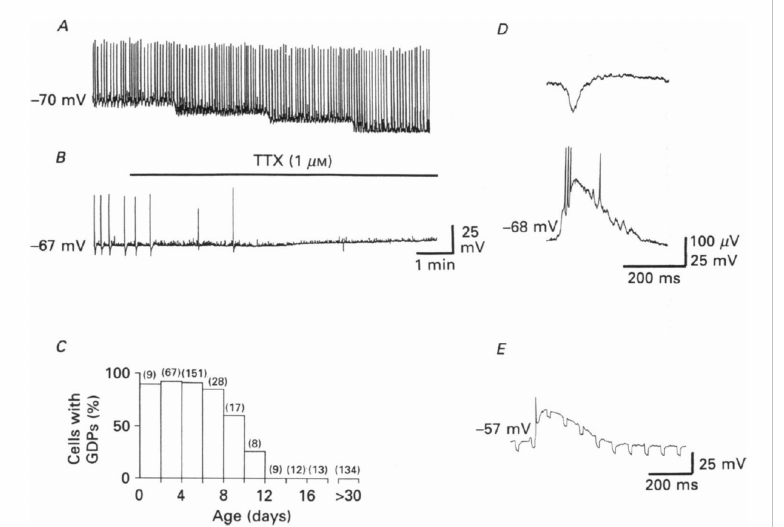
Figure 1. Giant depolarizing potentials (GDPs) and depolarizing actions of GABA in immature hippocampal pyramidal neurons. This is the first description of GDPs, which are synaptic events readily blocked by TTX ( A , B ). They are present during the first 12 days of post-natal life in rodents ( C ); ( D ) concomitant extracellular ( upper trace ) and intracellular ( lower trace ) recordings of a GDP; ( E ) spontaneous GDPs associated with an increase in input conductance, as shown by changes in electrotonic potentials resulting from injection of constant hyperpolarizing current pulses ( − 200 pA) through the recording electrode. From